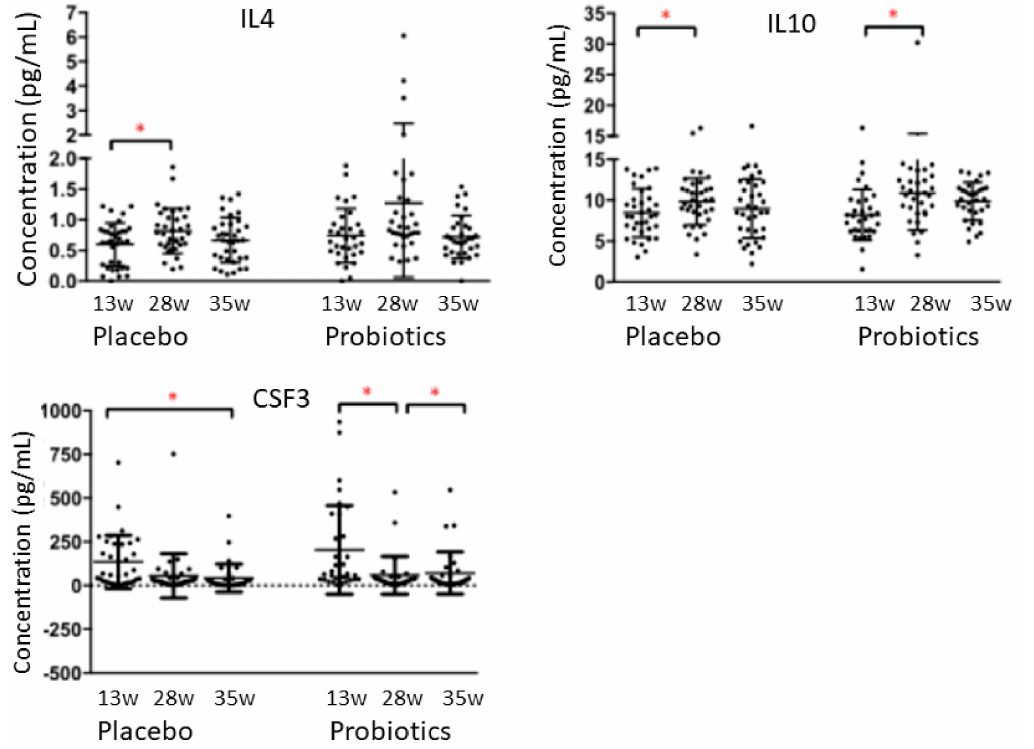
Figure 6. Concentrations of cervico-vaginal cytokines IL-4, IL-10 and CSF3 across gestation in pregnant women who received either placebo or probiotic treatment. Results are mean values ± SD and are expressed in picogram per milliliter. Comparison between the placebo group ( n = 33) and the probiotic group ( n = 31) was assessed with the Generalized Estimation Equation model in R. * = p <